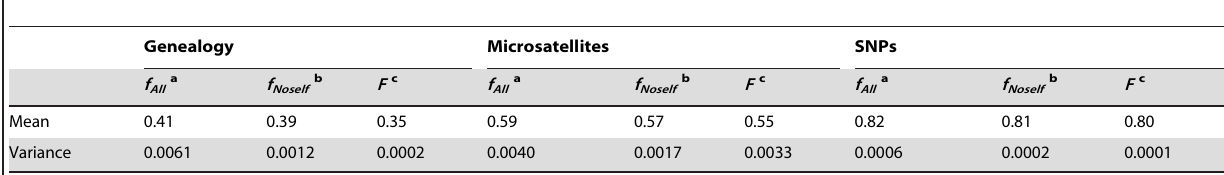
Table 3. Mean and variance of coancestry and inbreeding coefficients calculated using genealogical, microsatellite or SNP